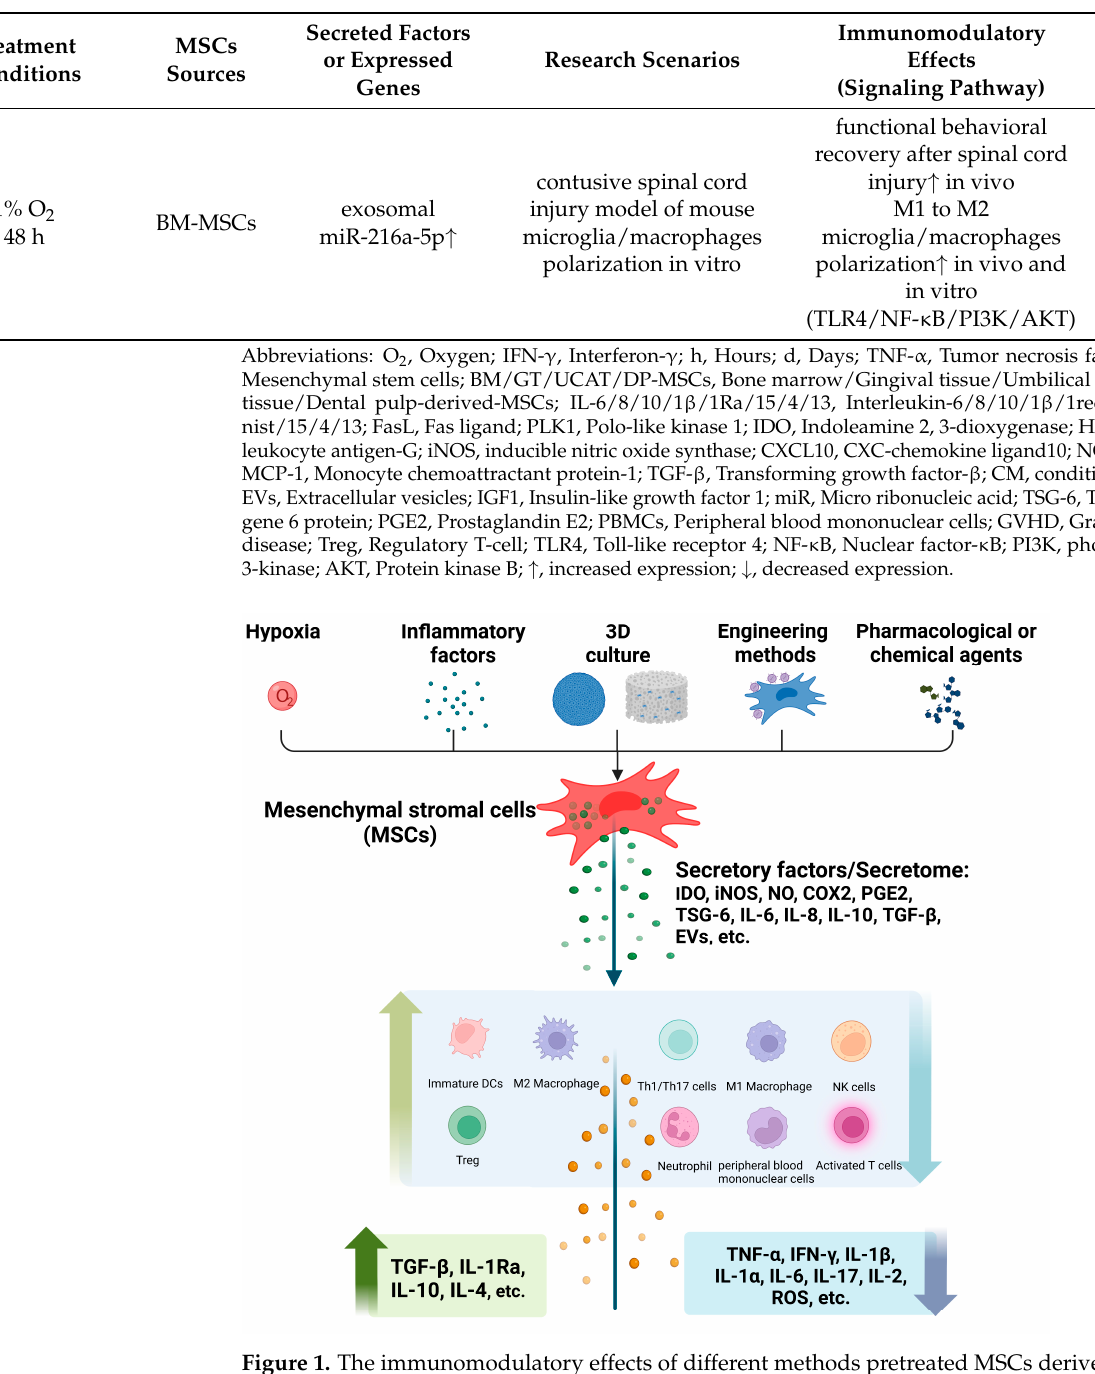
Figure 1. The immunomodulatory effects of different methods pretreated MSCs